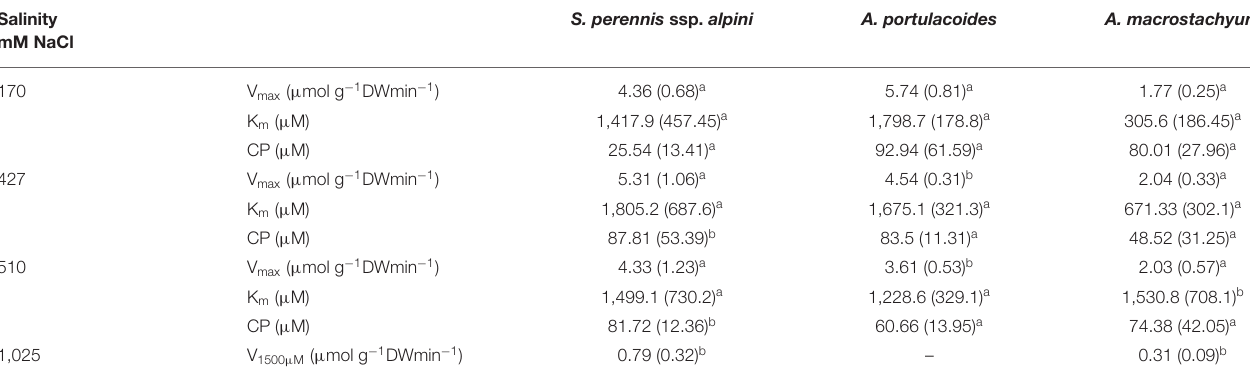
TABLE 2 | Kinetic parameters of ammonium uptake curves measured at different salinities in the three species of this study. Salinity mM NaCl